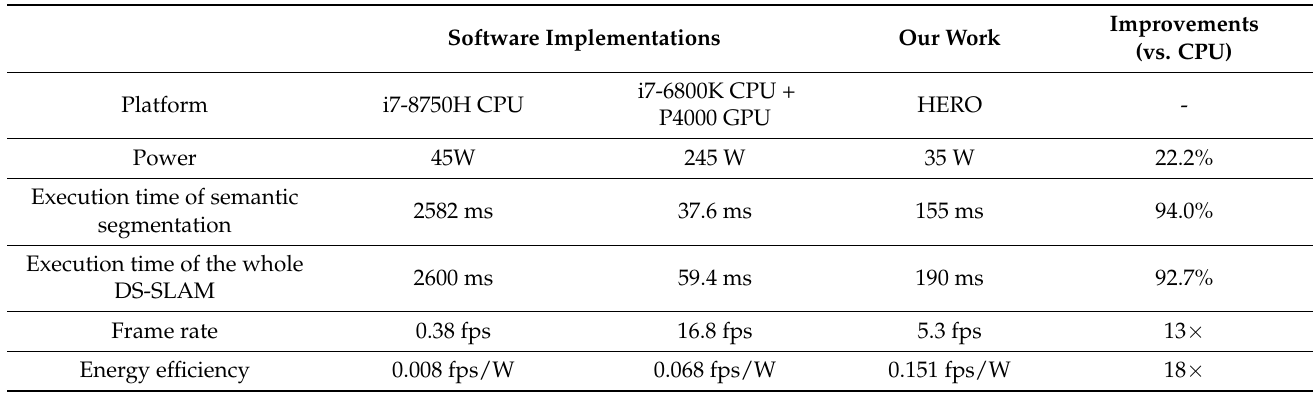
Table 3. Execution time, frame rate, power consumption, and energy efficiency comparison